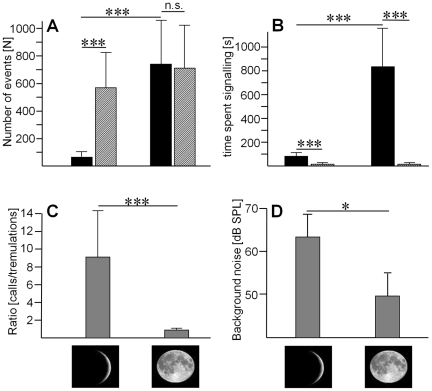
The amount of signalling in the private and public mode depends on nocturnal light conditions.The amount of calling vs. tremulations (hatched and black bars, respectively) (A), the time spent signalling (B) and the ratio of calls vs. tremulations (C) differs significantly between new-moon and full-moon nights. (D) The overall sound-pressure level is significantly reduced by 13.6 dB under full-moon conditions compared to under new-moon conditions.